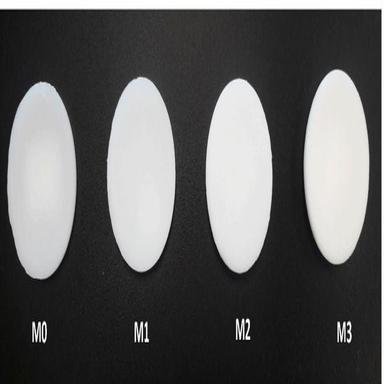
Synthesized nano-enhanced eutectic composites.